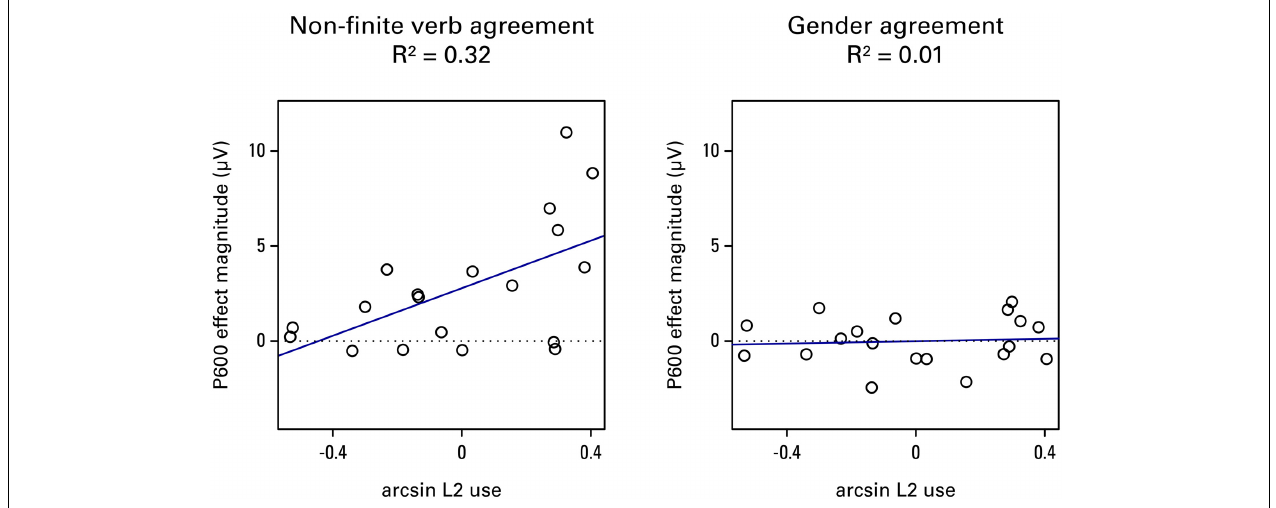
FIGURE 7 | The percentage of use of the L2 in daily life predicts P600 magnitude for non-finite verb agreement violations, but not gender agreement violations.